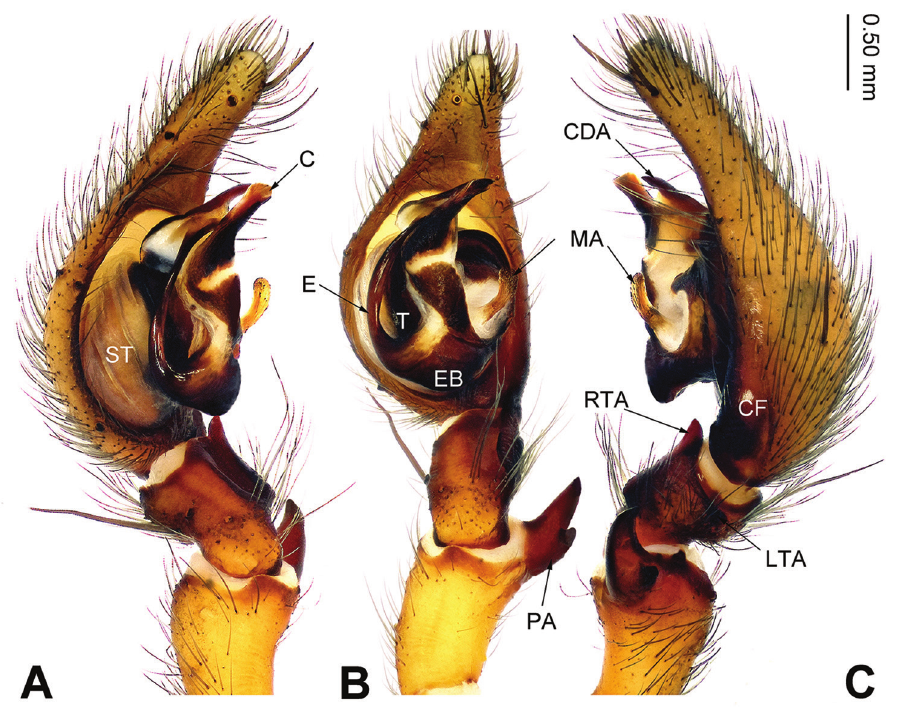
Figure 5. Left male palp of Sinodraconarius muruoensis sp. n., holotype. A Prolateral view B Ventral view C Retrolateral view. Scale bar equal for A, B, C